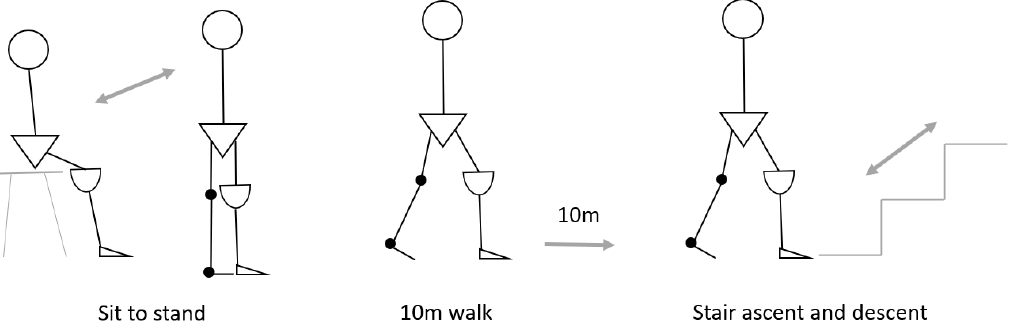
Figure 2. Description of three functional activities where pressure measurement were